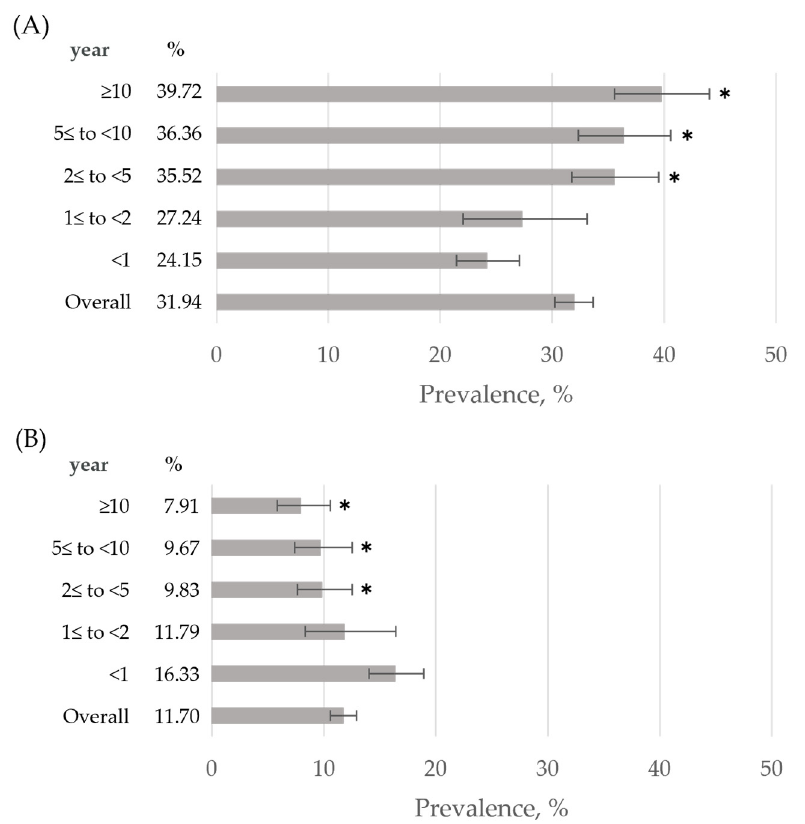
Figure 2. Prevalence of dyskalemia stratified by dialysis vintage at baseline period. ( A ) Prevalence of hyperkalemia ( n = 909) during the baseline period by length of dialysis vintage. ( B ) Prevalence of hypokalemia ( n = 333) during the baseline period by length of dialysis vintage [Hypo-K group ( n = 313) and patients with both hyperkalemia and hypokalemia ( n = 20)]. Error bars denote 95% confidence intervals. * p < 0.01 versus dialysis vintage of <1 year (the Benjamini–Hochberg Procedure was used to correct for multiple